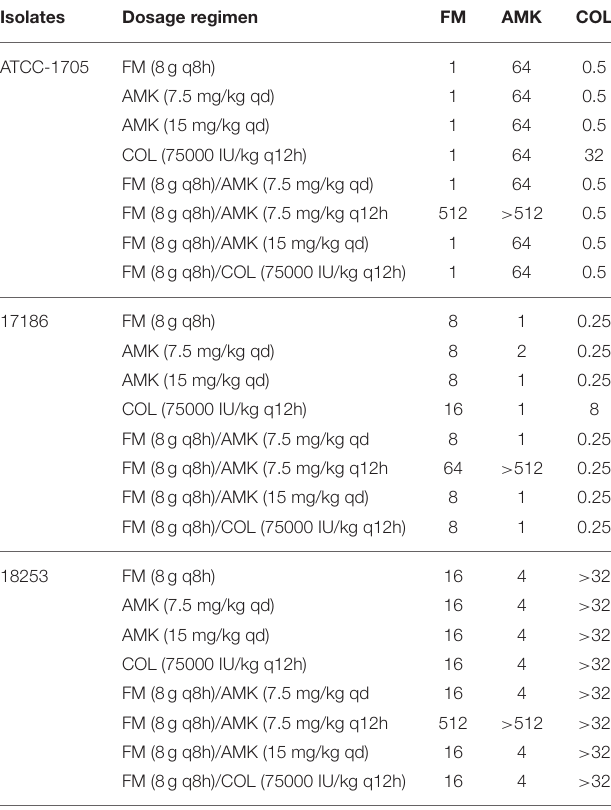
TABLE 3 | Minimum inhibitory concentrations of fosfomycin, colistin, and amikacin against three KPC-producing K. pneumoniae strains after 24 h in pharmacokinetics simulation studies.